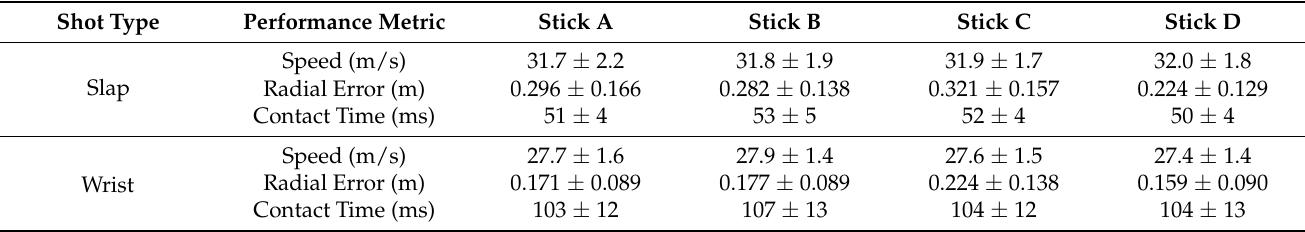
Table 5. Ensemble average speed, accuracy, and release quickness metrics with each stick for slap and wrist shots ± SD ( n =